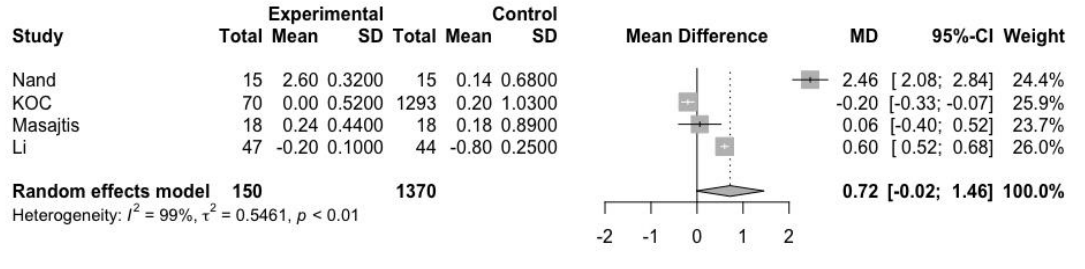
Figure 8. Mean difference of change-from-baseline value of Hb between statin group and control group.